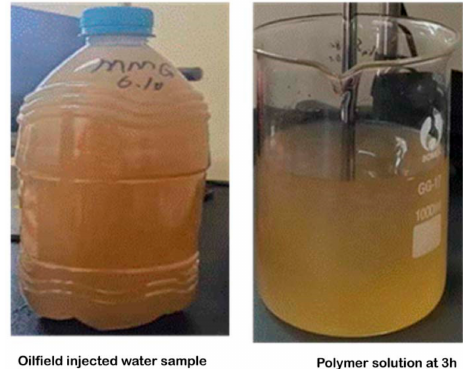
Figure 13. Injected water sample and polymer solution at 3 h.